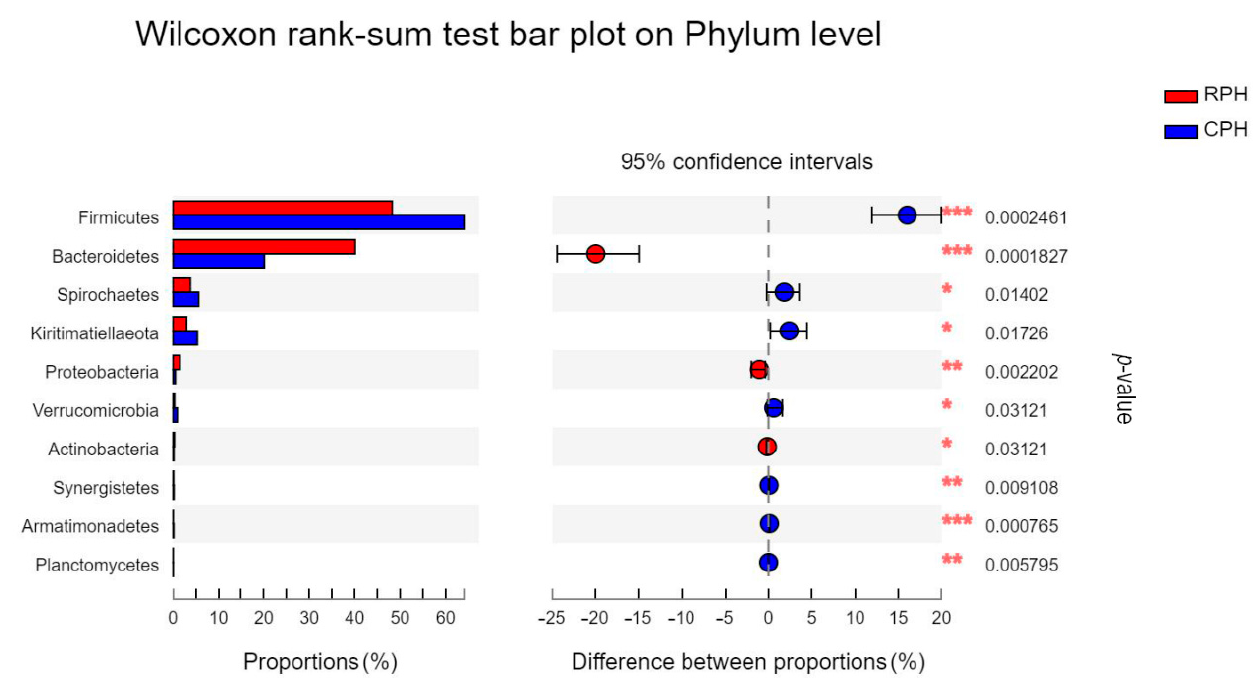
Figure 5. The bar plot shows the bacterial phylum with significant differences among the CPH and RPH. * p < 0.05, ** p < 0.01 and *** p <